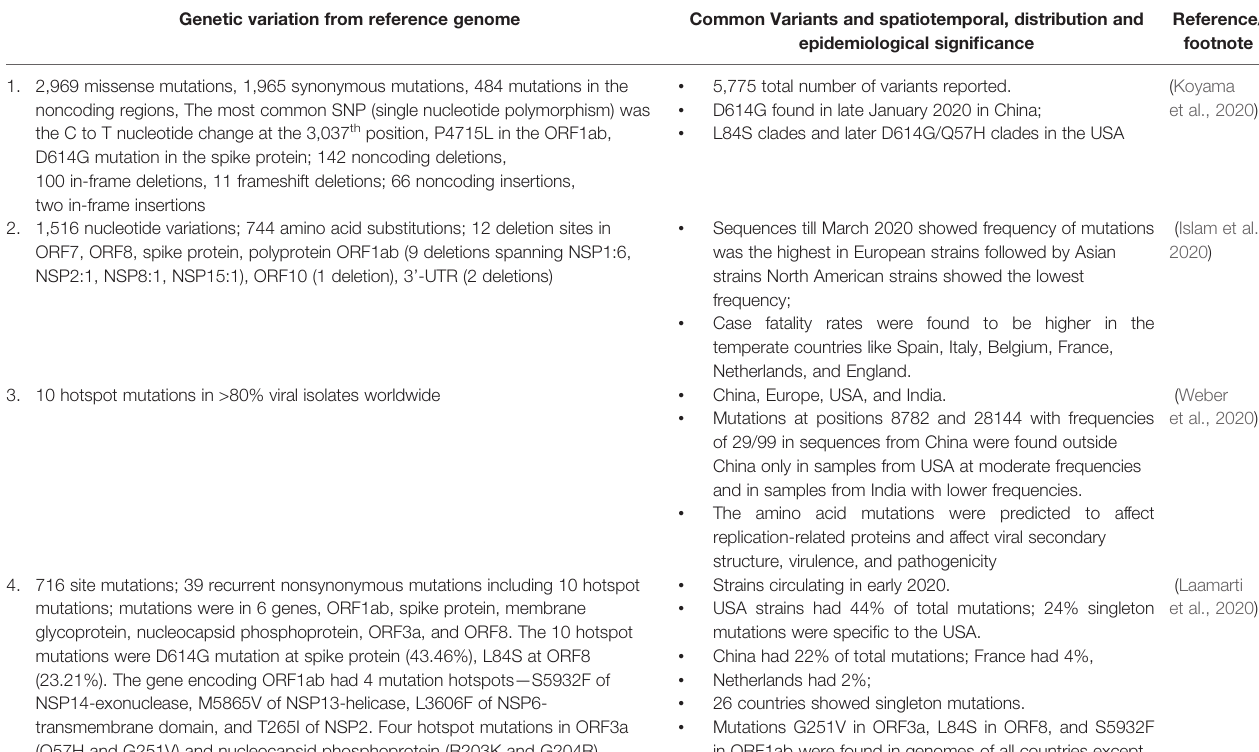
TABLE 1 | Genetic variants of